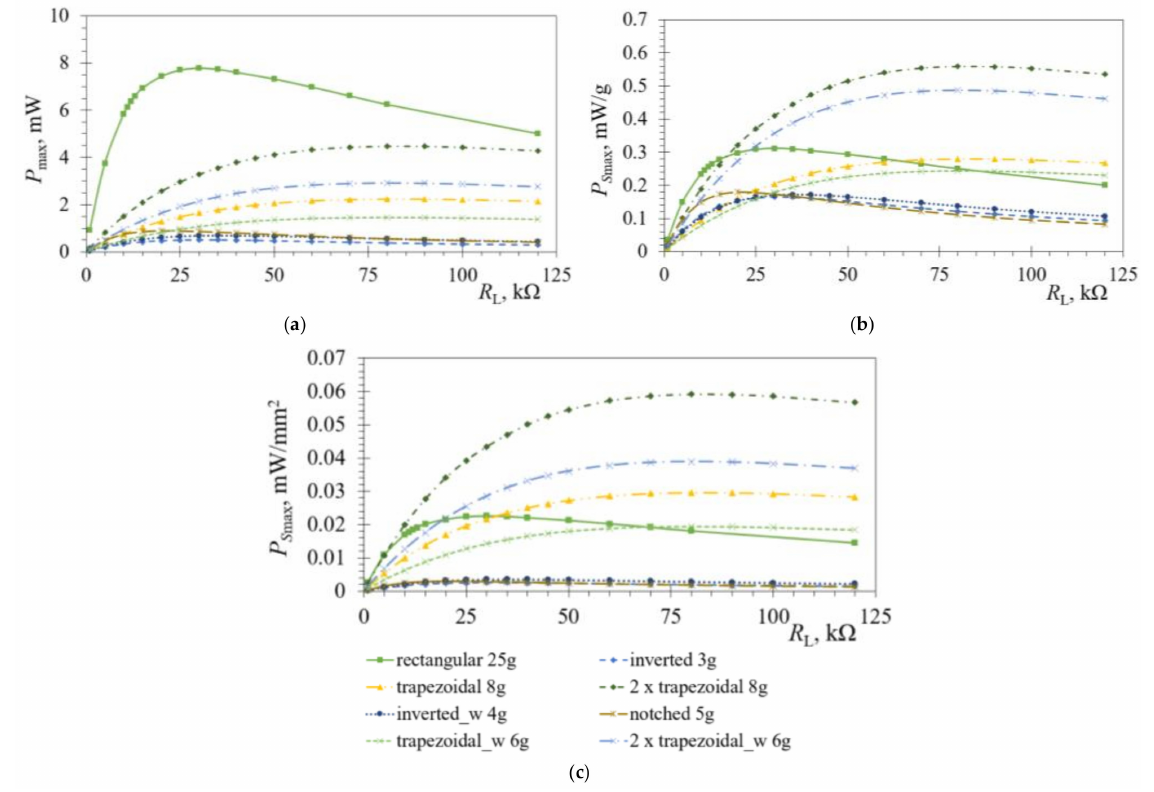
Figure 11. Coupled harmonic responses of the various PEH shapes with optimal tip masses m : P max ( a ), P Smax normalised by m ( b ), and P Smax normalised by the PEH surface area ( c ) vs. R L